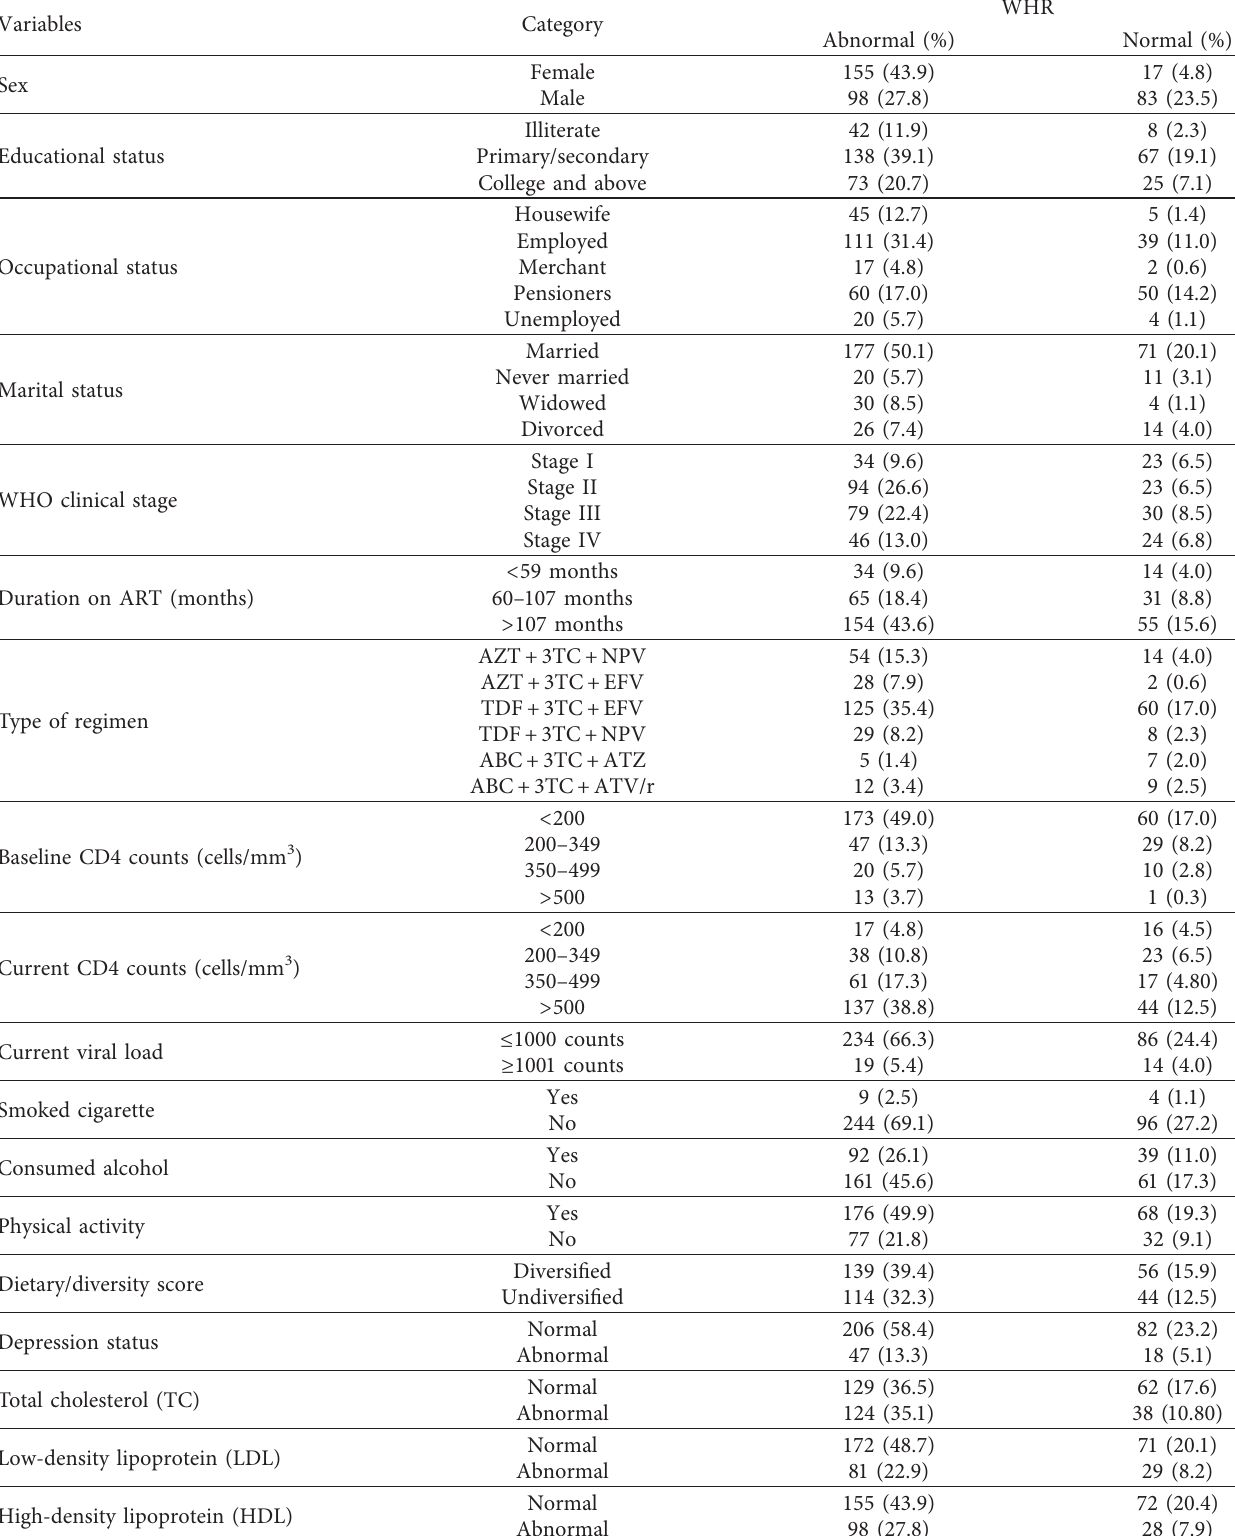
Table 4: Prevalence of central obesity among HIV patients who received ART at armed force comprehensive and specialized hospital, Ethiopia, 2018 ( n �